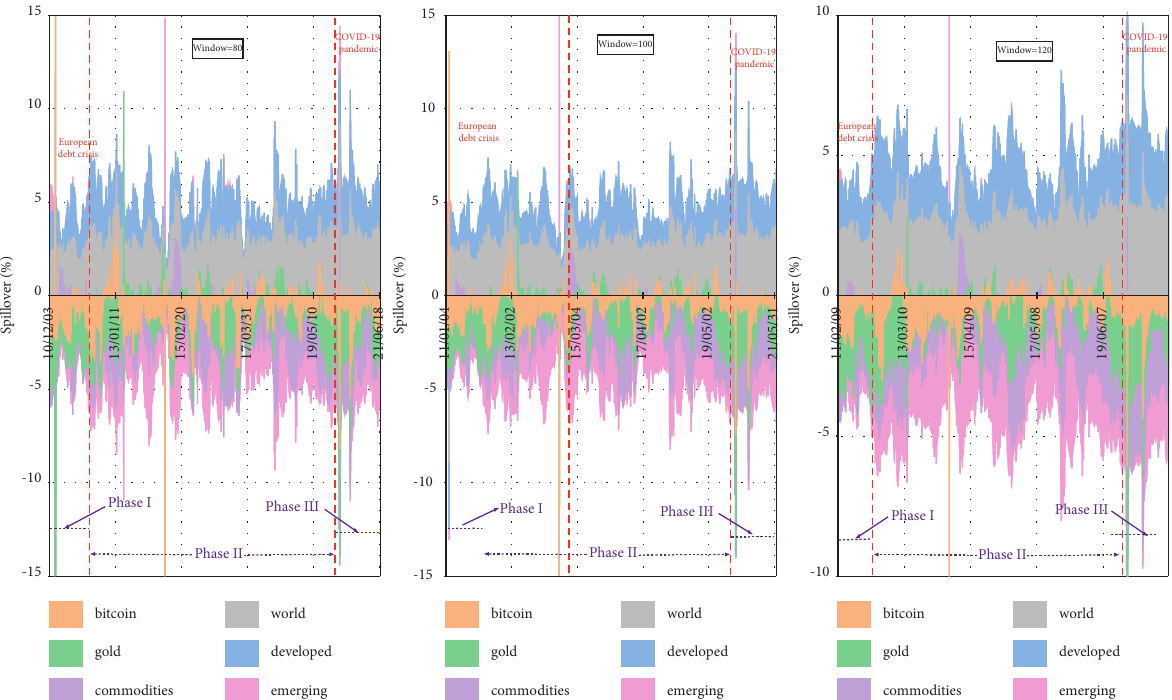
Figure 6: Dynamic net spillover with different rolling windows. The red dotted line defines the time points that distinguish three sample phases. The three window sizes plot the dynamic return total spillover measures on the 80 (the sample period for returns is from December 8, 2010, to June 23, 2021), 100 (the sample period for returns is from January 4, 2011, to June 23, 2021), and 120 (the sample period for returns is from February 9, 2011, to June 23, 2021.). All abbreviations are as follows: bitcoin, gold, and commodities indices (commodities); the world stock index (world); the developed stock index (developed); and the emerging stock index